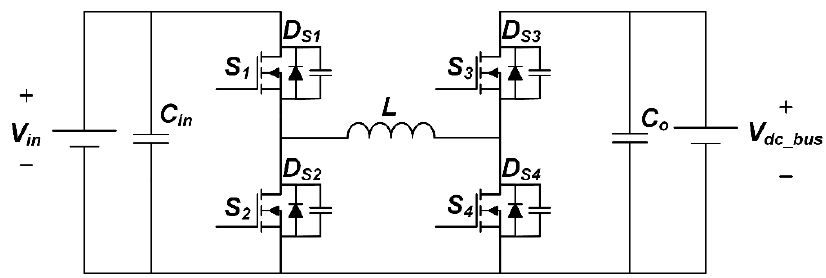
Figure 4. Cascaded bidirectional buck–boost/half-bridge DC–DC converter.